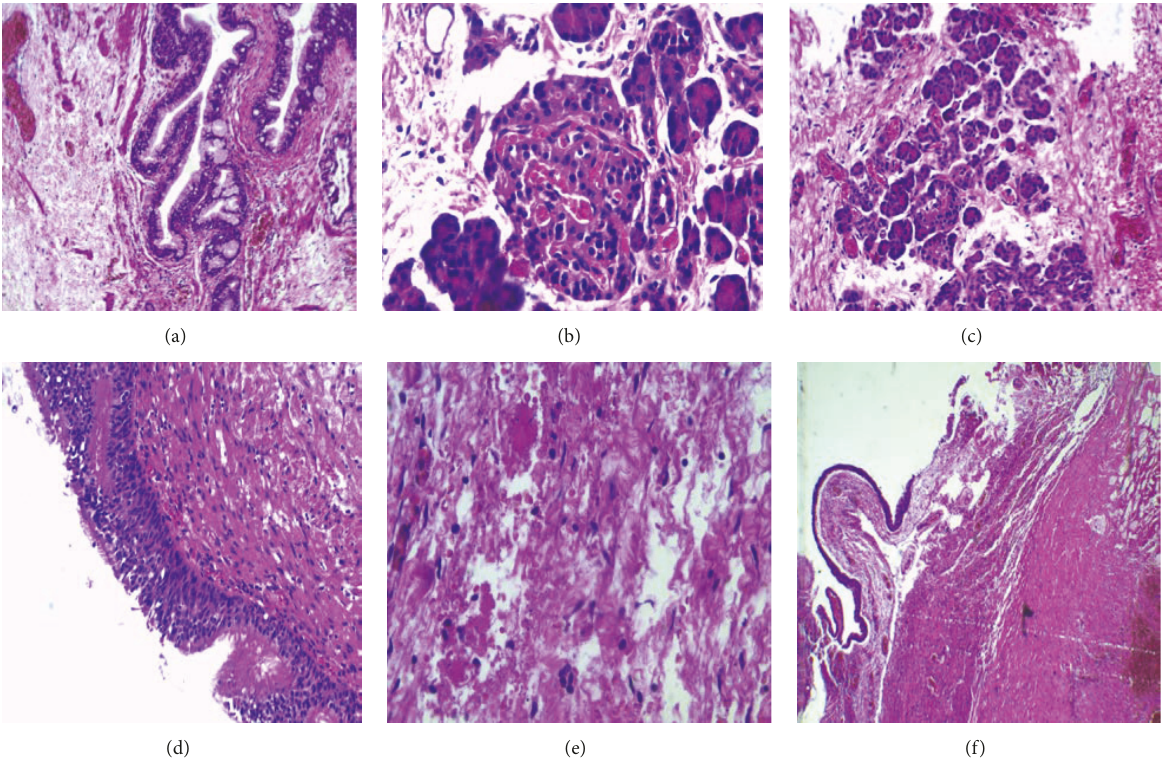
Figure 5: Histological examination of the resected mass [HE.GX20]: (a) regular glandular gastric mucosa into sclerotic and muscular tissue. (b) Hepatic regular tissue. (c) Pancreatic tissue showing pancreatic islets of Langerhans. (d) Columnar pseudo-stratified-ciliated respiratory epithelioma. (e) Mature nervous tissue. (f) Pericardium with strips of Malpighian